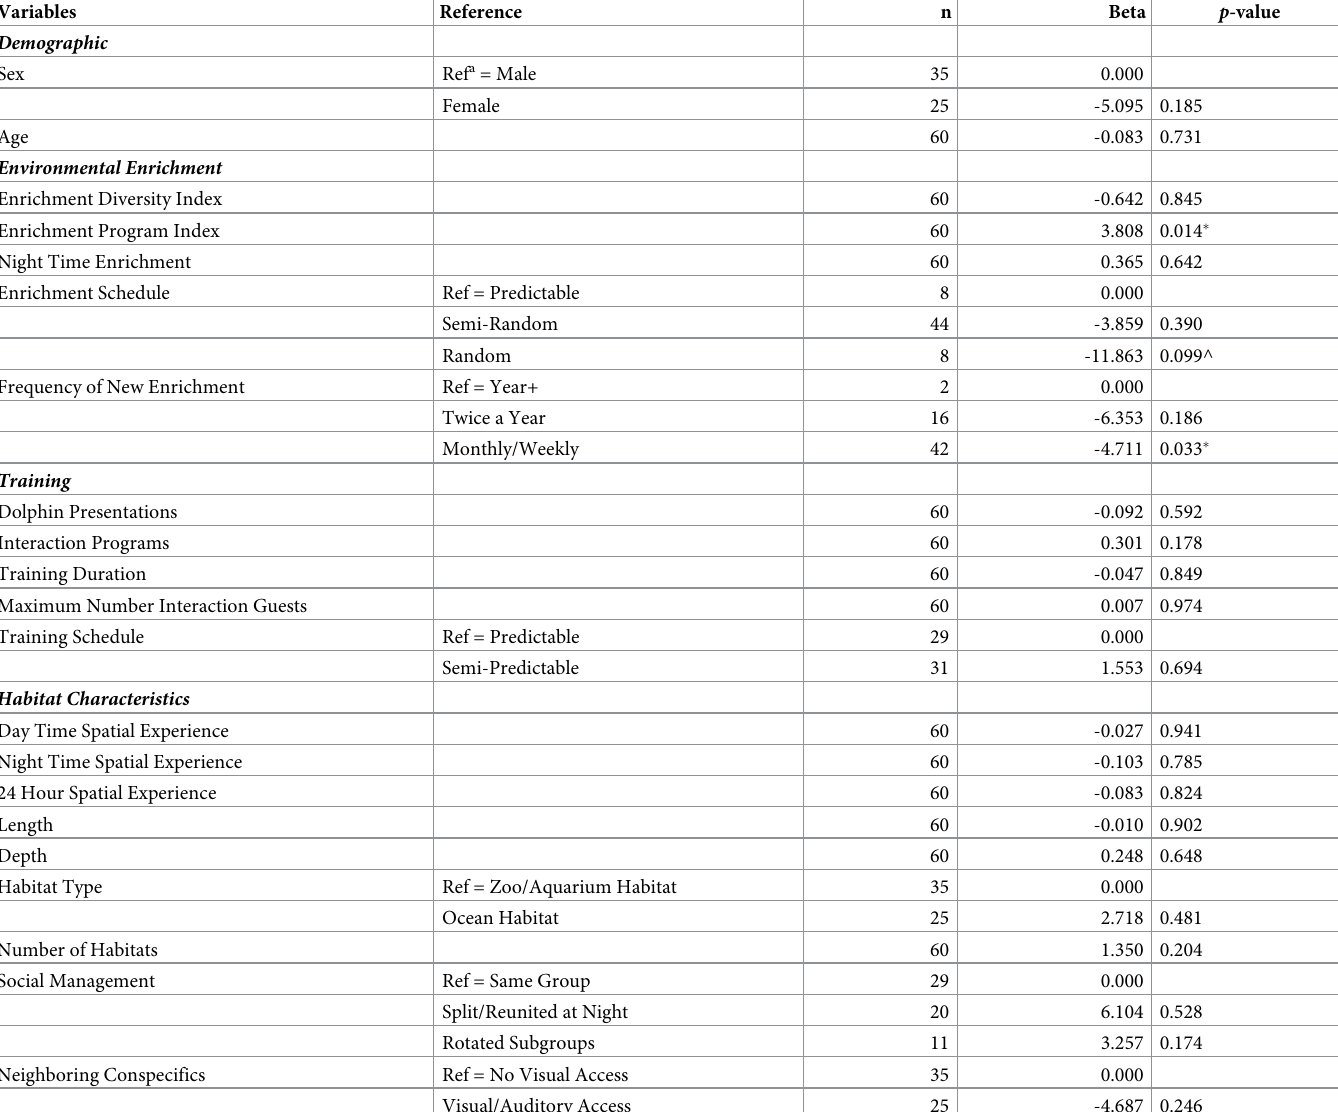
Table 2. Univariate correlations between dive duration and independent